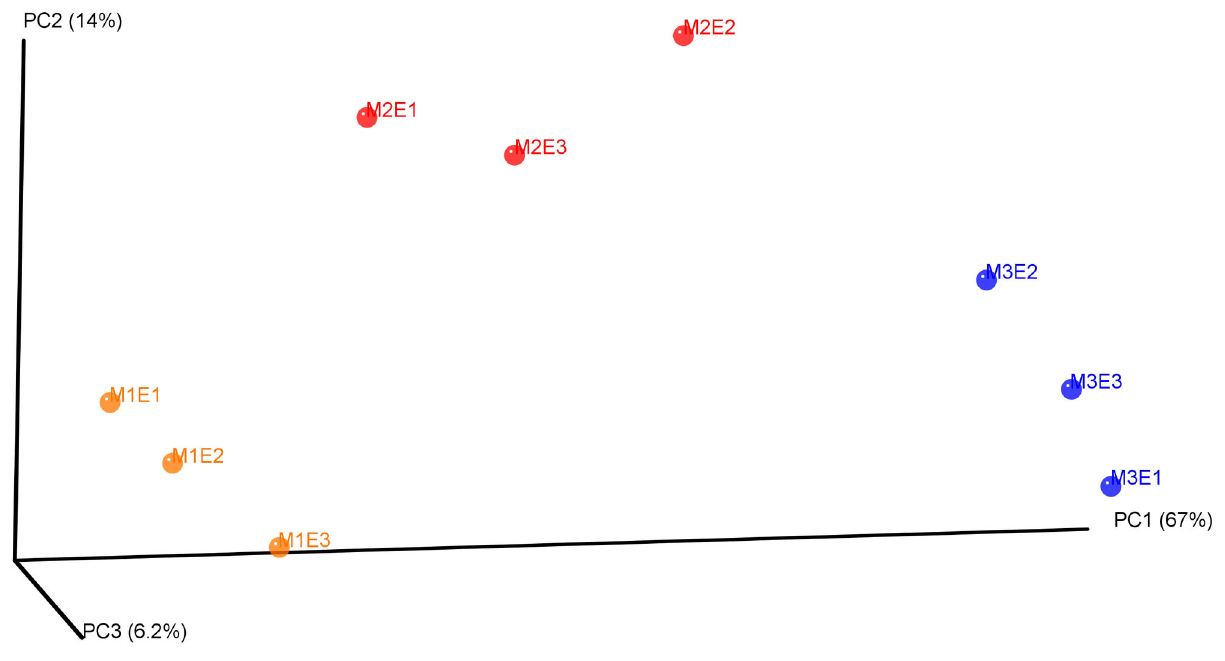
Figure 3. β-diversity analysis of the microcosms composition. Phylogenetic dataset analyzed using jackknifed PCoA of the weighted pairwise UniFrac distances. The undiluted, 10 2 - and 10 4 -diluted microbiotas are respectively represented by orange, red and blue plain circles. doi: